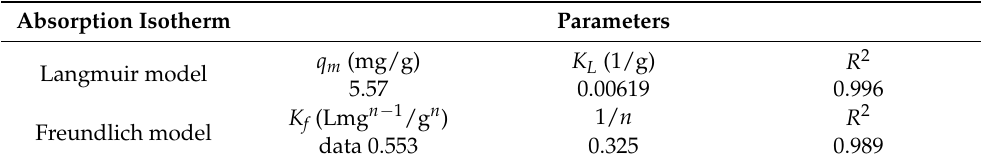
Figure 2. Experimental adsorption equilibrium results for the absorption of Cr(VI) onto the simulated sorbent for soil remediation. Error bars show the standard deviation of five replicates. Table 2. Langmuir and Freundlich isotherm parameters for Cr(VI) absorption on the simulated sorbent in soil remediation.